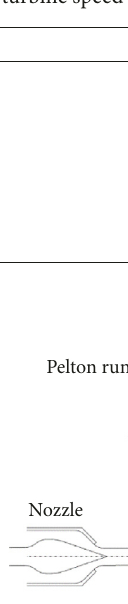
Table 3: Calculation summary to determine the turbine speed (𝑁) and PCD.